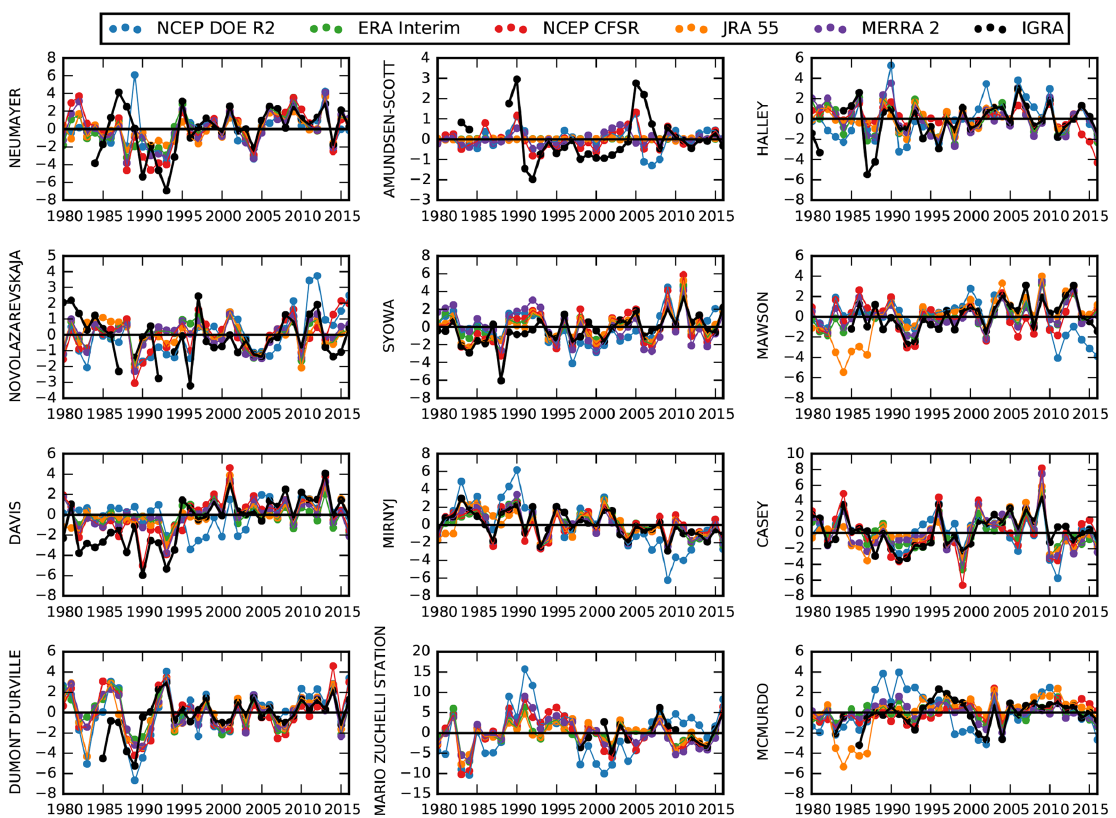
Figure 9. Time series of vertically integrated moisture transport anomalies into East Antarctica (in kgm − 1 s − 1 ) at the location of the selected stations in observations and reanalyses.